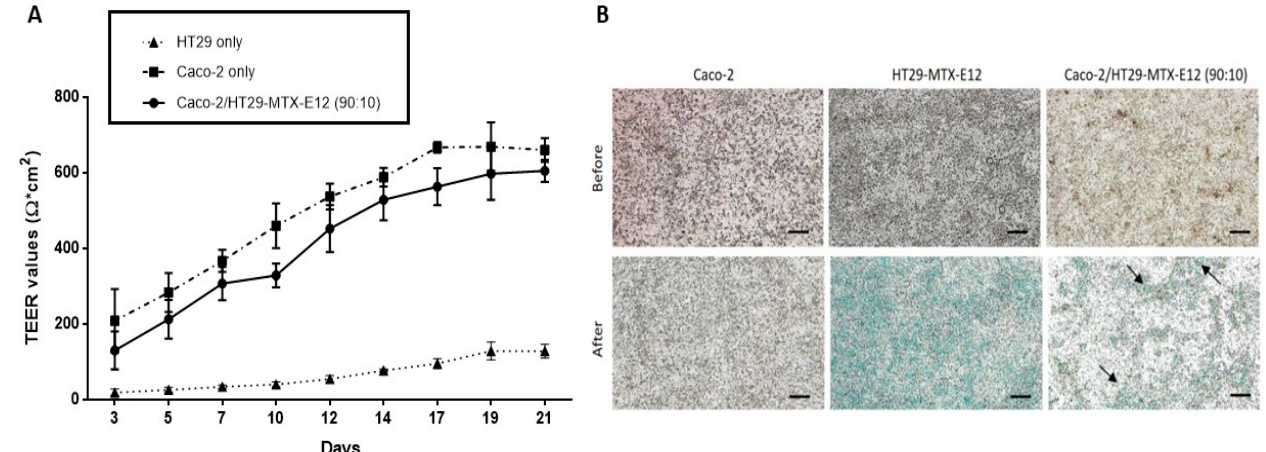
Figure 3. Characterization of the Caco-2/HT29-MTX-E12 (90:10 ratio) co-culture during 21 days of cultivation. ( A ) Transepithelial-transendothelial electrical resistance (TEER) values of Caco-2, HT29- MTX-E12, and Caco-2/HT29-MTX-E12 (90:10) cell cultures. Values are shown as mean ± standard deviation (SD) ( n ≥ 3). ( B ) Representative microscopy images of cell layers were obtained before and after staining with Alcian blue for mucus production (evident by blue color and black arrows). Scale bar = 100 µ